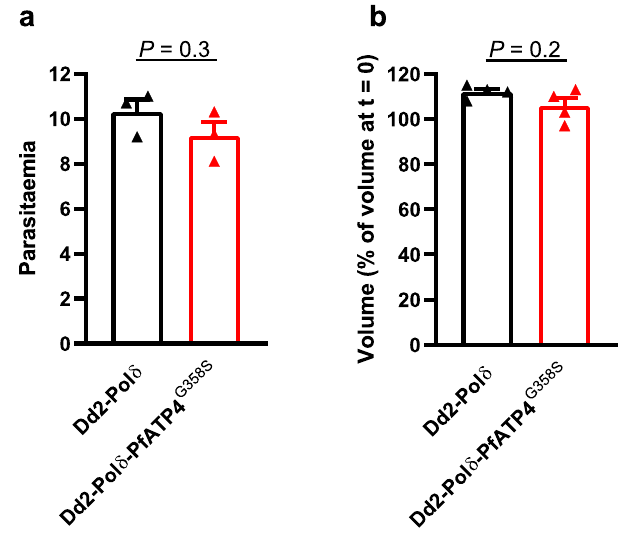
Fig. 7 | Production of viable daughter parasites and progression through the erythrocyticcycleissimilarinDd2-Pol δ -PfATP4 G358S (red)andDd2-Pol δ (black) parasites. a The parasitaemias obtained one cycle (~48h) after adjusting the parasitaemia of cultures to 1%. The bars show the mean from three independent experiments, each performed on different days with three cultures (technical replicates). b Parasite volume (as a percentage of that measured at 0h) after one cycle (48h) of growth. The bars show the mean from four independent experi- ments, each performed on different days with at least two technical replicates. In ( a ) and ( b ), the error bars are SEM, and the symbols show the data from each independent experiment. The P valuesare from two-tailed unpaired t tests. Source data are provided as a Source Data fi